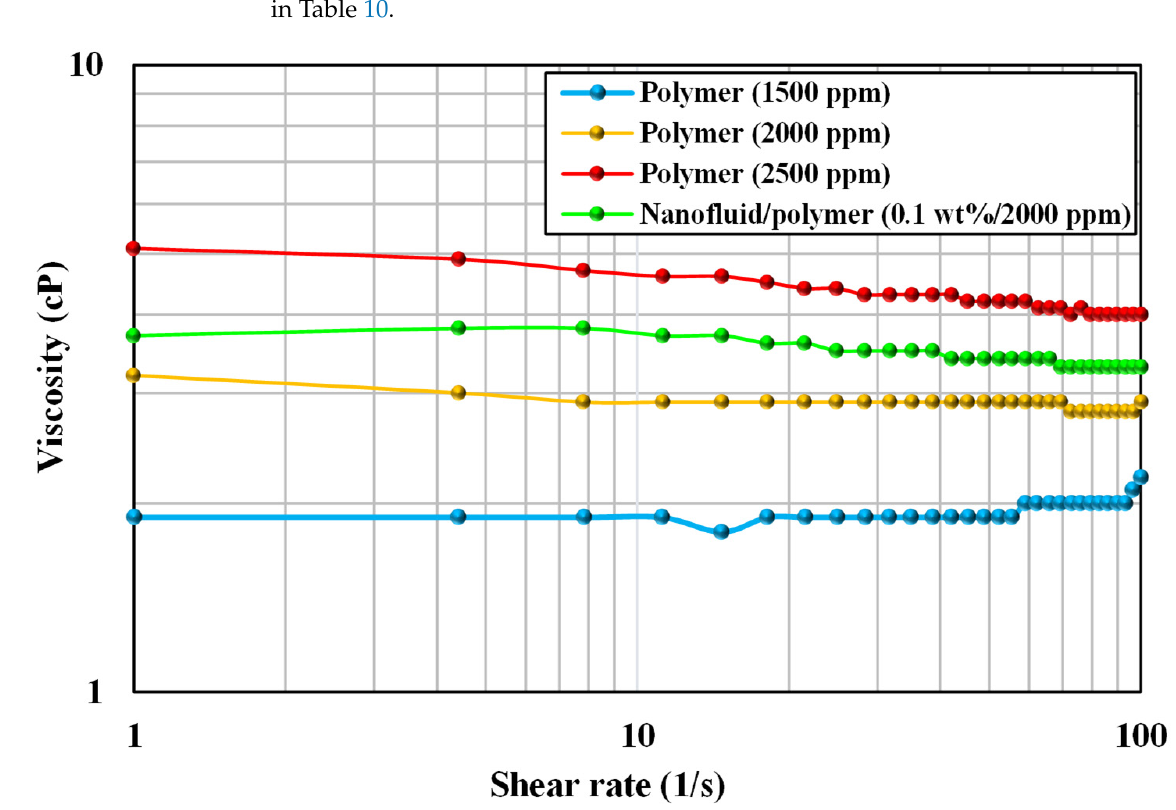
Table 10. Rheology of pure polymer solutions at high temperatures.